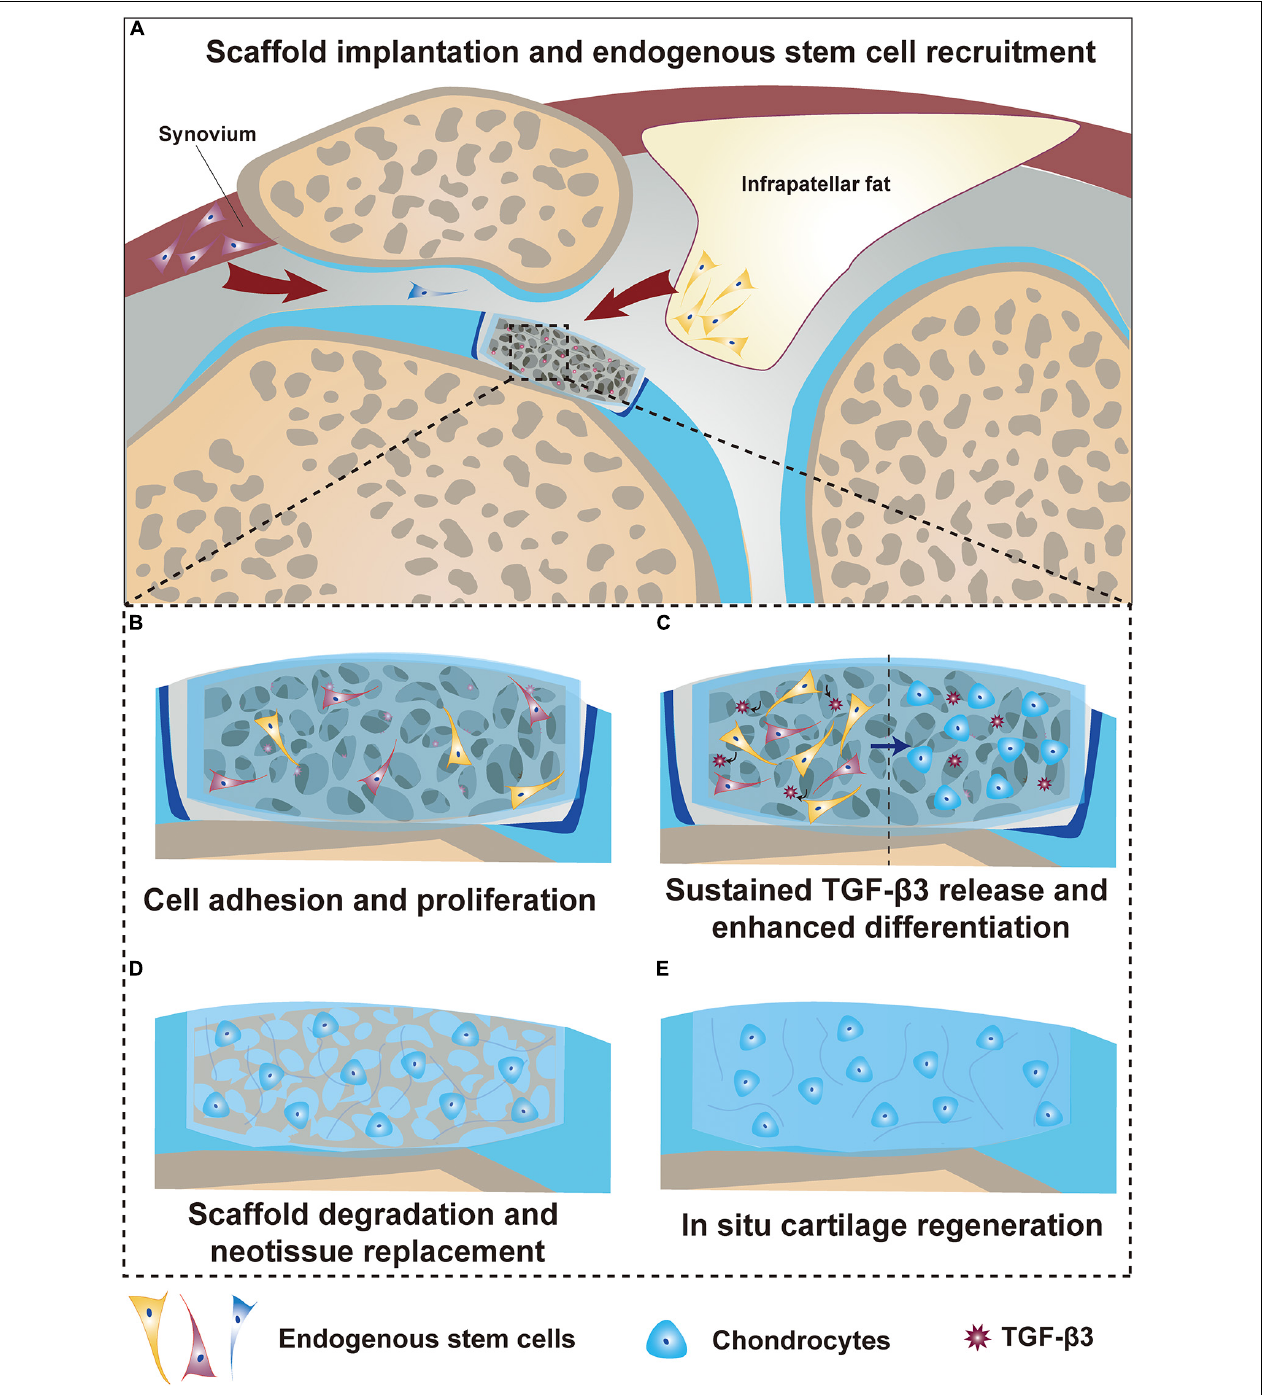
FIGURE 8 | Summarized schematic of the mechanism of in situ cartilage regeneration. (A) Scaffold implantation and endogenous stem cell recruitment. (B) Stem cell adhesion and proliferation. (C) Sustained TGF- β 3 release and enhanced stem cell differentiation. (D) Scaffold degradation and neotissue replacement. (E) In situ articular cartilage